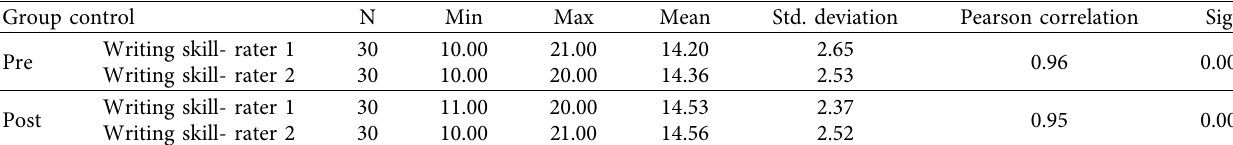
Table 11: Interrater reliability between the two raters in the upper-intermediate group (pretest and posttest). Group control N